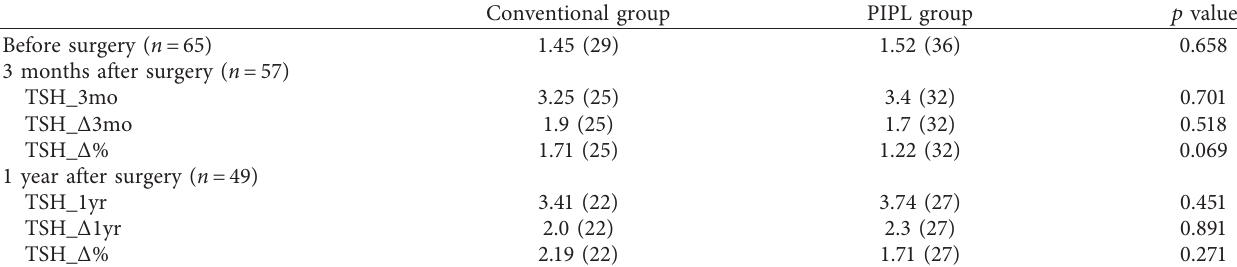
Table 2: Comparisons of the mean TSH concentrations before surgery, and 3 months and 1 year after surgery. Conventional group